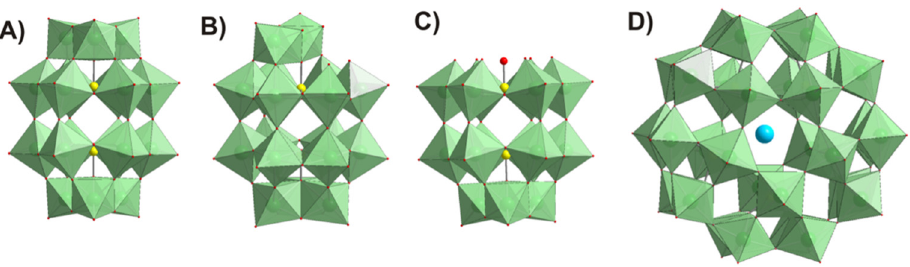
Figure 1. Polyhedral representation of POT structures tested in this study: ( A ) intact Wells-Dawson anion [ α -P V2 W VI18 O 62 ] 6 − P 2 W 18 ; ( B ) mono-lacunary Wells-Dawson anion [ α 2 -P V2 W VI17 O 61 ] 10 − P 2 W 17 ; ( C ) anion [ α -P V 2 W VI 18 O 62 ] 6 − P 2 W 18 ; ( B ) mono-lacunary Wells-Dawson anion [ α 2 -P V 2 W VI 17 O 61 ] 10 − tri-lacunary Wells-Dawson anion [P V2 W VI15 O 56 ] 12 − P 2 W 15 ; ( D ) Preyssler anion [NaP V5 W VI30 O 110 ] 14 − P 2 W 17 ; ( C ) tri-lacunary Wells-Dawson anion [P V 2 W VI 15 O 56 ] 12 − P 2 W 15 ; ( D ) Preyssler anion P 5 W 30 . Color code: {WO 6 }, green; P, yellow; O, red; Na, cyan. [NaP V 5 W VI 30 O 110 ] 14 − P 5 W 30 . Color code: {WO 6 }, green; P, yellow; O, red; Na,